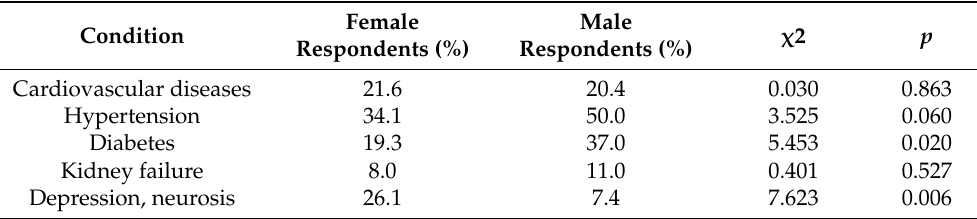
Table 2. Characteristics of the study group showing the relationship of the observed diseases with the age of the